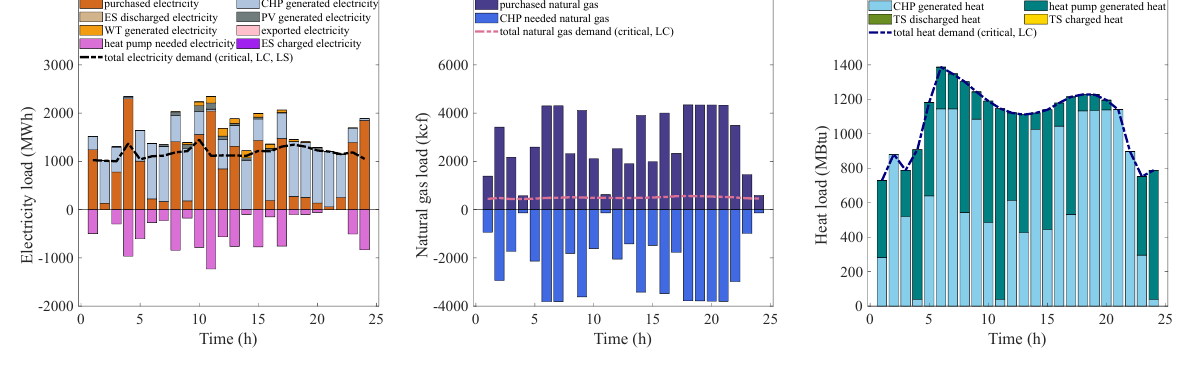
Figure 6. Operational results of microgrid 1.